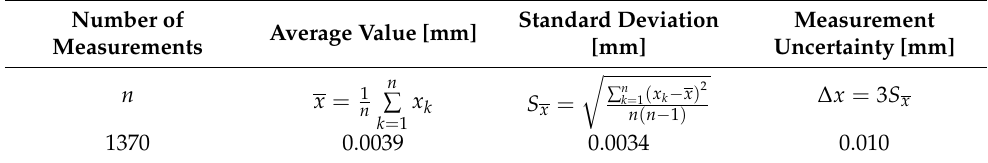
Table 4. Measurements uncertainty using ARAMIS.